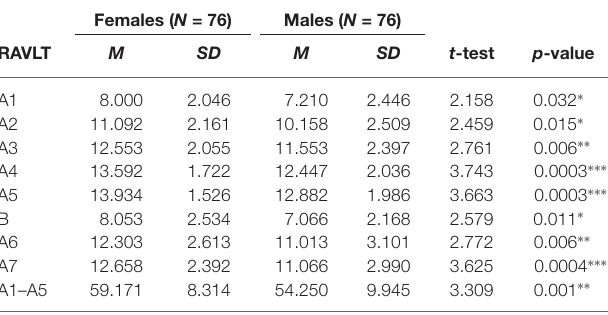
TABLE 2 | The comparison of Rey Auditory-Verbal Learning Test (RAVLT) results in females and males. Females ( N = 76)